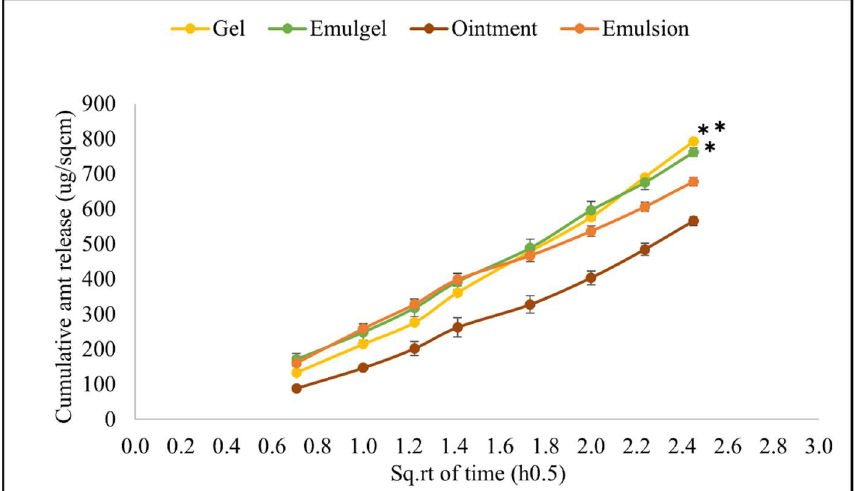
Figure 6. In vitro release profile of different semi-solid formulations, ** indicates p < 0.01 and statistically significant in comparison to all other formulations, * indicates p < 0.01 and statistically significant in comparison to emulsion and ointment. Data shown are Mean ± SD of six replicates.